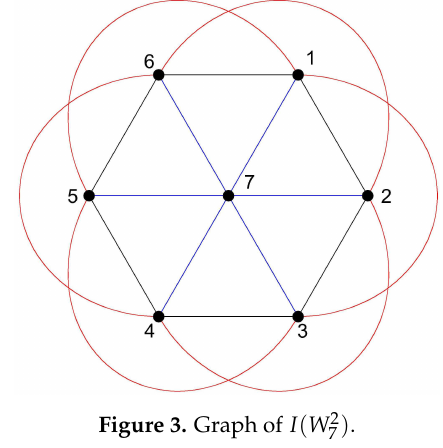
Figure 3. Graph of I ( W 2